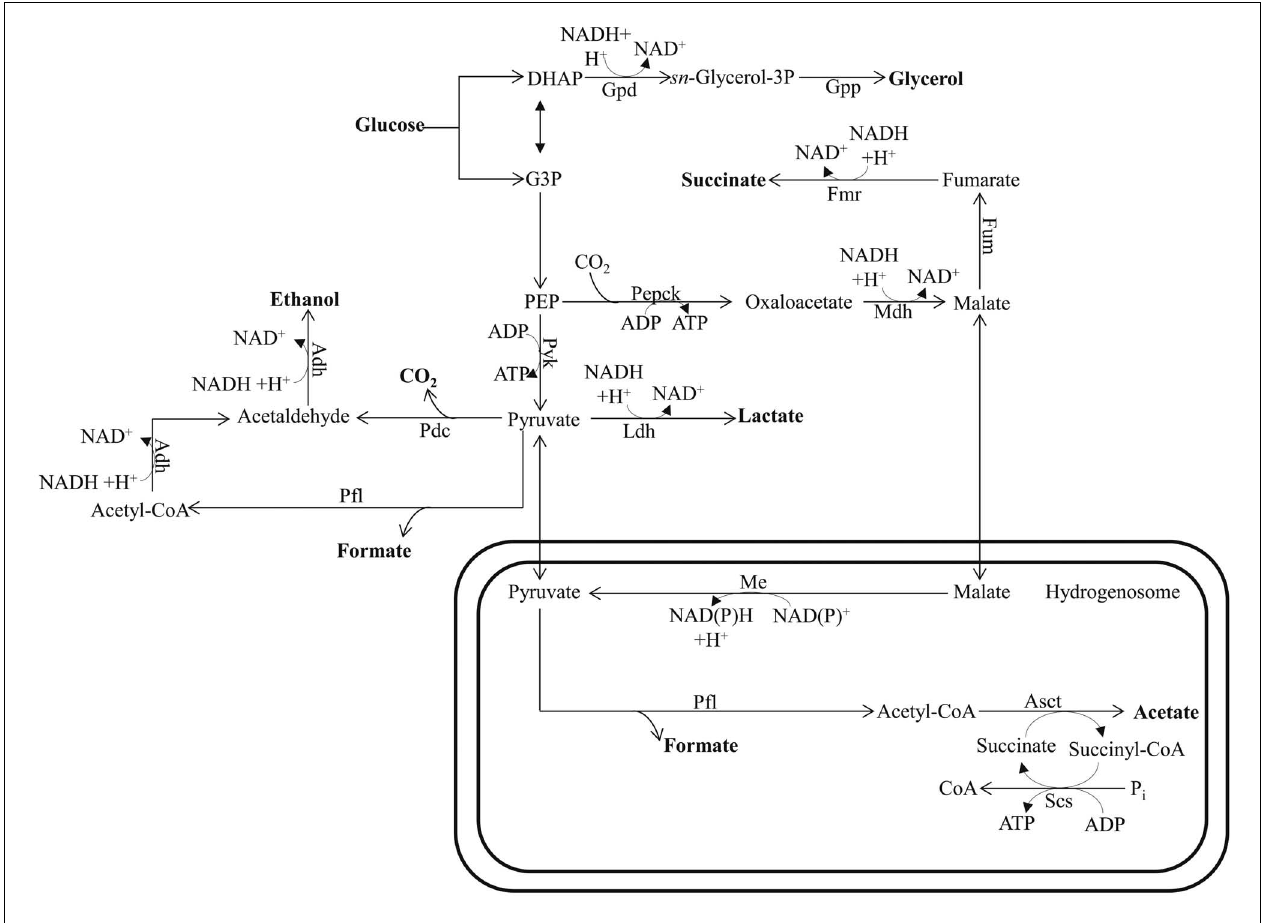
FIGURE 4 | Mixed-acid fermentative metabolism of the hydrogenosome-bearing anaerobic chytridiomycete fungus Piromyces . The circuitry is drawn based on data reported byWang etal. (2001) and Boxma etal. (2004).This fungus uses pyruvate formate lyase for pyruvate catabolism in their hydrogenosomes. Glucose can also be metabolized in the cytosol to the end products succinate, lactate, formate, and ethanol. Bifunctional alcohol dehydrogenase (Adh), having both alcohol dehydrogenase